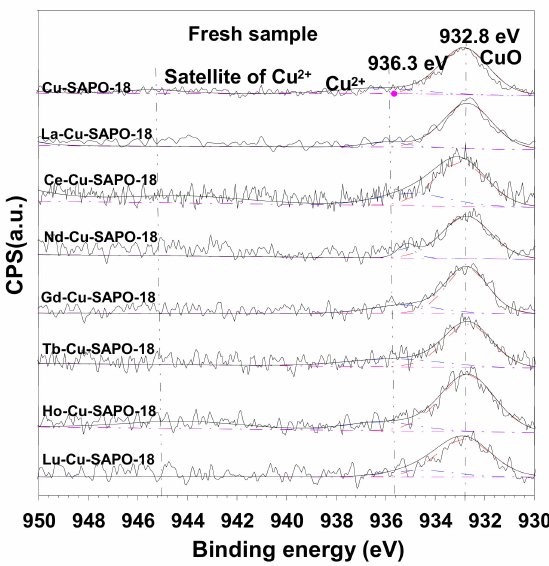
Figure 6. Cu 2p 3 / 2 XPS spectra of the fresh Cu-SAPO-18 and M-Cu-SAPO-18